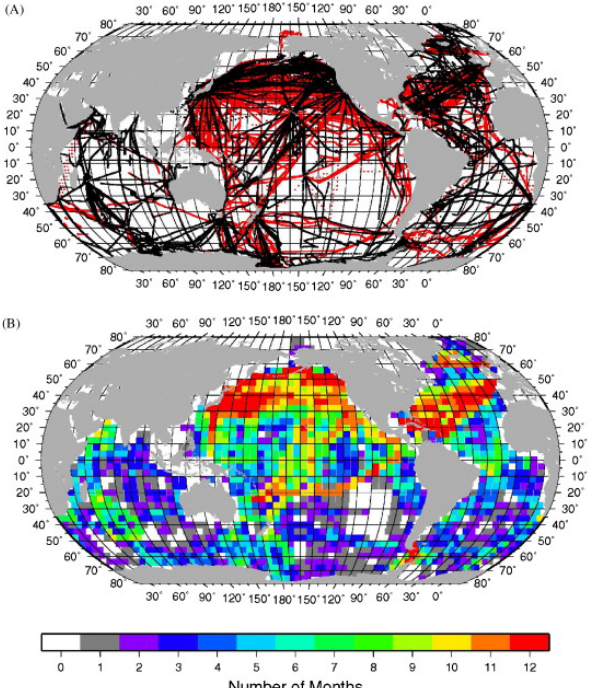
Fig. 2. The upper figure shows the location of observations of oceanic p CO 2 based on 3 million observations collected since 1958 (Takahashi et al., 2009). The lower panel shows the number of months of the year for which observations exist. These data are the basis of the observational data used in this study (reproduced from Takahashi et al.,